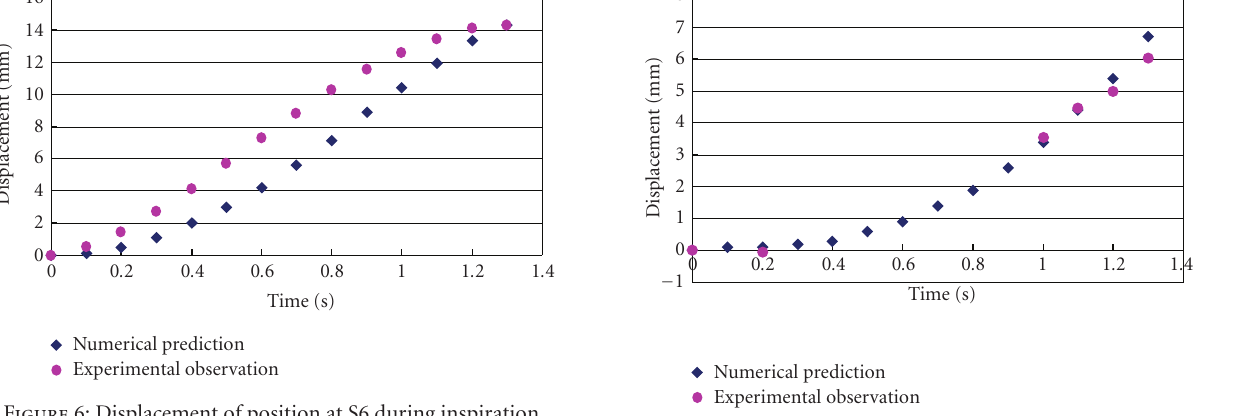
Figure 8: Displacement of position at S3 during